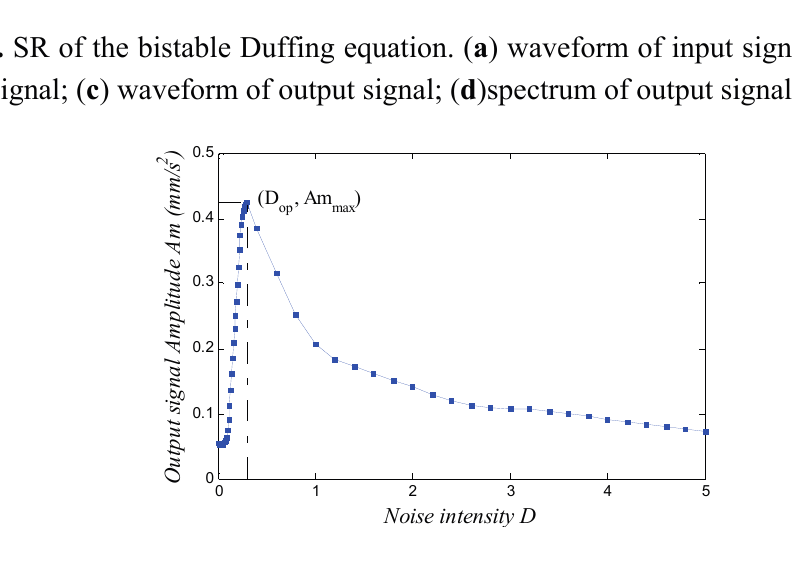
Figure 3. Response curve of the output signal amplitude against noise